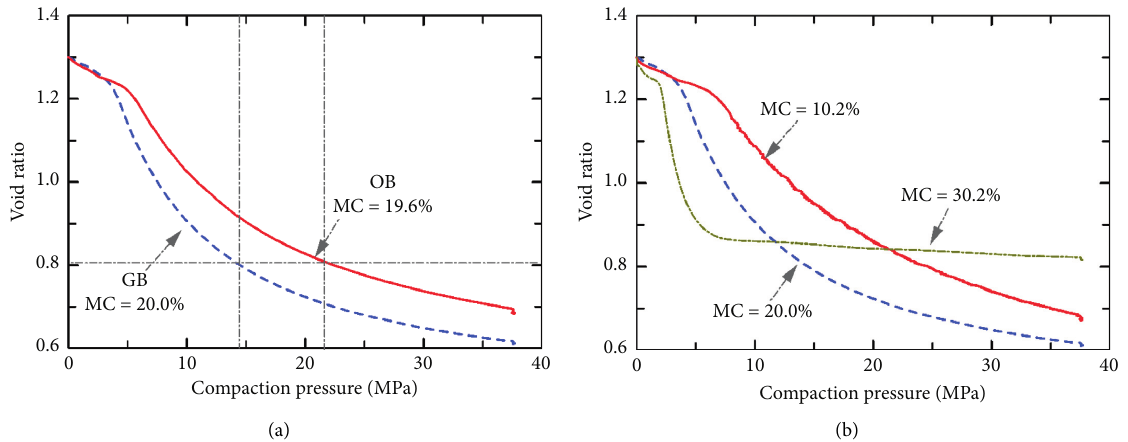
Figure 14: Compression curves. (a) Original and granular bentonites with the same initial void ratio and moisture content (MC). (b) Granular bentonite with the same initial void ratio and different moisture contents.